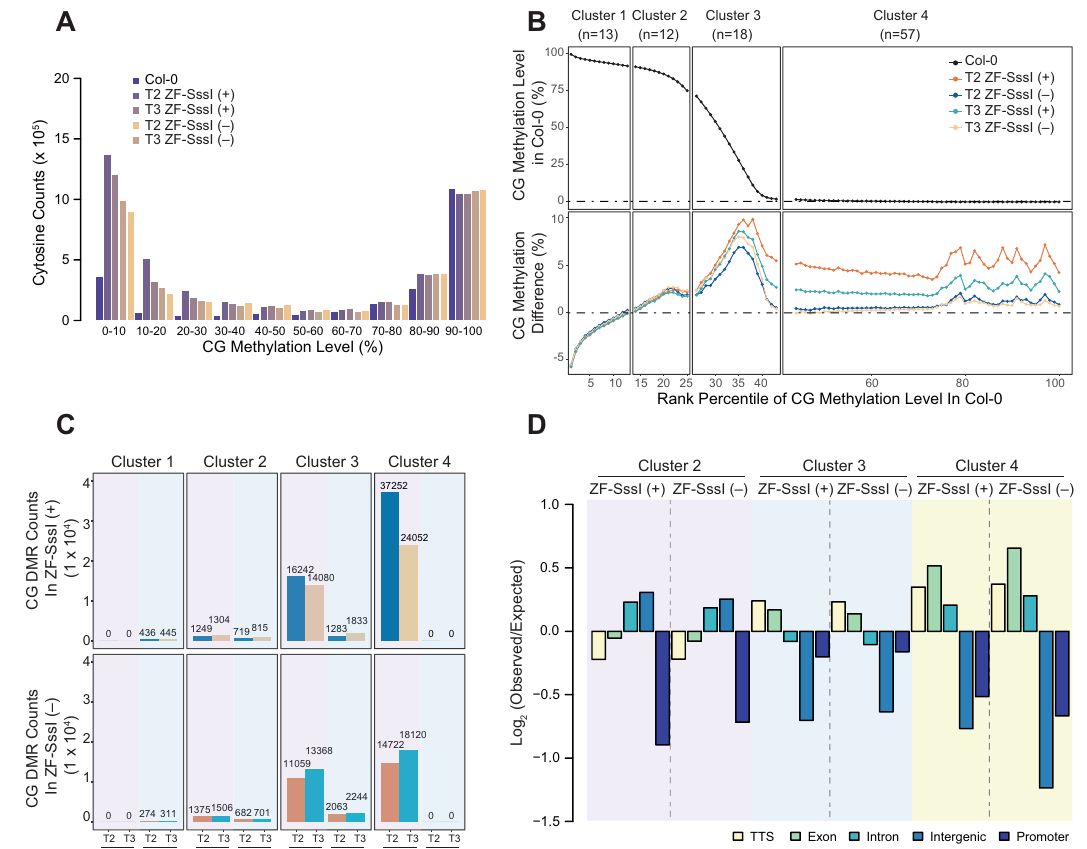
Fig. 3 Characteristics of hyper CG-methylated sites in ZF-SssI. A CG cytosine counts grouped by CG methylation level in Col-0 and ZF-SssI lines during T2 and T3 with ( + ) or without ( ‒ ) the transgene. B CG methylation level of 200 bp bins in Col-0 (upper panel) and CG methylation difference in ZF-SssI lines during T2 and T3 with ( + ) or without ( ‒ ) the transgene (lower panel) ranked by the CG methylation level in Col-0. Methylation difference is the absolute difference in CG methylation levels between ZF-SssI lines and Col-0. Four clusters are de fi ned by the methylation level of 200 bp bins in Col-0. N represents the number of ranked percentiles within the cluster. C Count of hyper and hypo differentially methylated regions (DMRs) in ZF-SssI lines during T2 and T3 with ( + ) or without ( ‒ ) the transgene in the four clusters. D Genomic distribution (Observed versus Expected) of the hyper CG DMRs in ZF-SssI lines during T2 and T3 with ( + ) or without ( ‒ ) the transgene in Clusters 2, 3, and